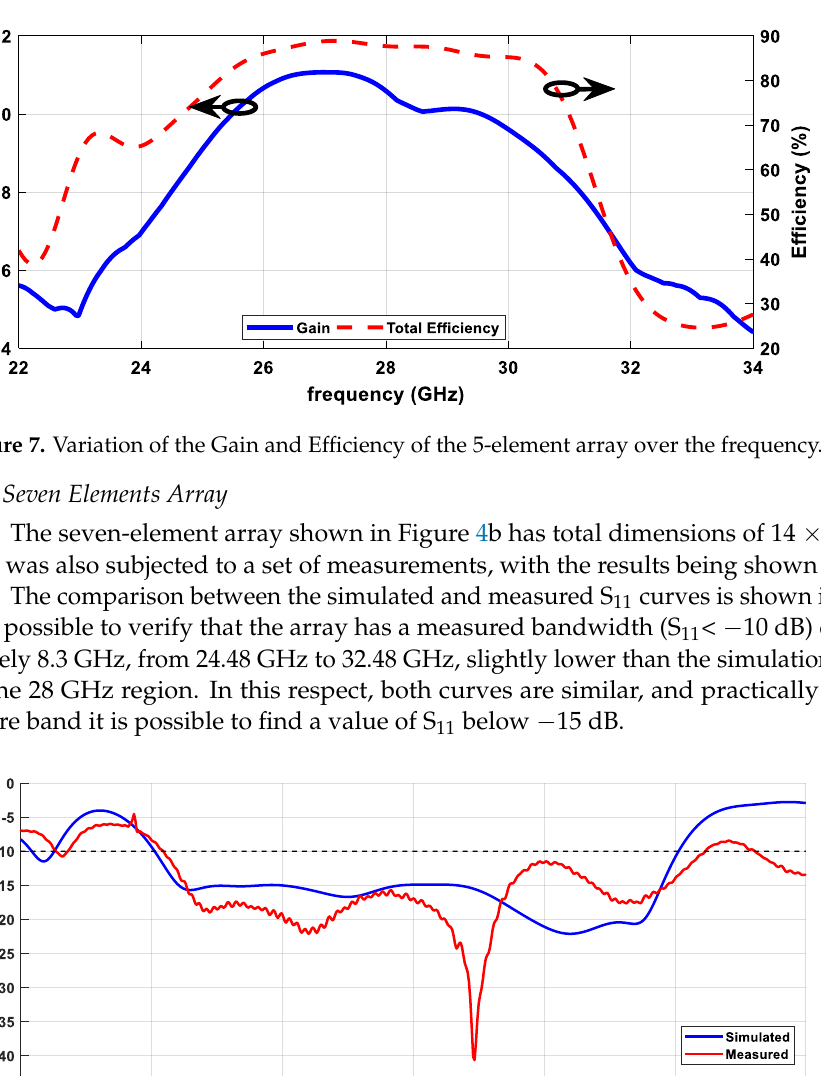
Figure 8. Simulated and measured reflection coefficient of the 7 elements antenna array.